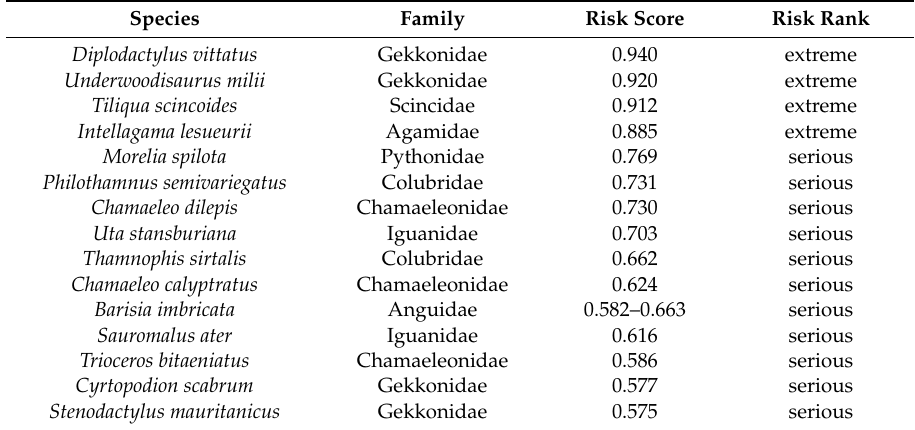
Table 1. Species of ornamental reptiles (excluding turtles) with highest potential to establish viable populations in the EU, based on the Risk Assessment model.